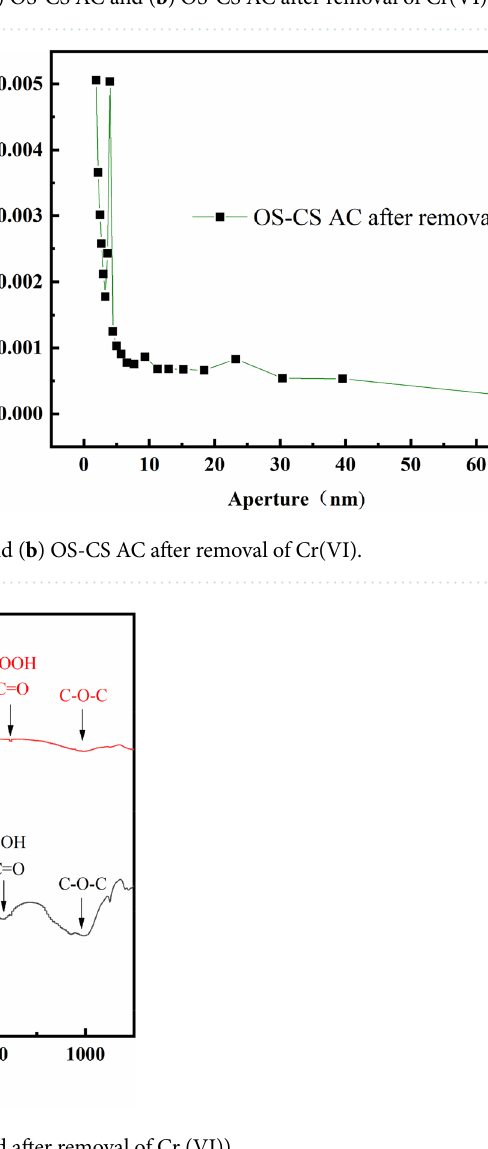
Figure 7. FT-IR spectra of OS-CS AC (before and after removal of Cr